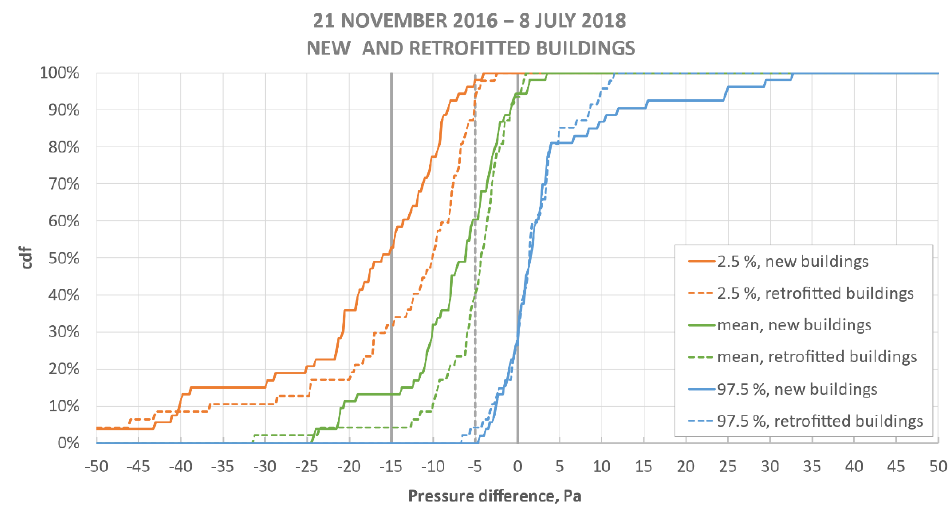
Figure 4. Cumulative distribution functions of 2.5% cdf values ( left ), mean ( center ), and 97.5% cdf values ( right ) of air pressure differences in all of the measurement points. The values for new (solid lines) and retrofitted buildings (dashed lines) are calculated from the whole measurement duration. Vertical lines describe the national guidelines for air pressure differences over the building